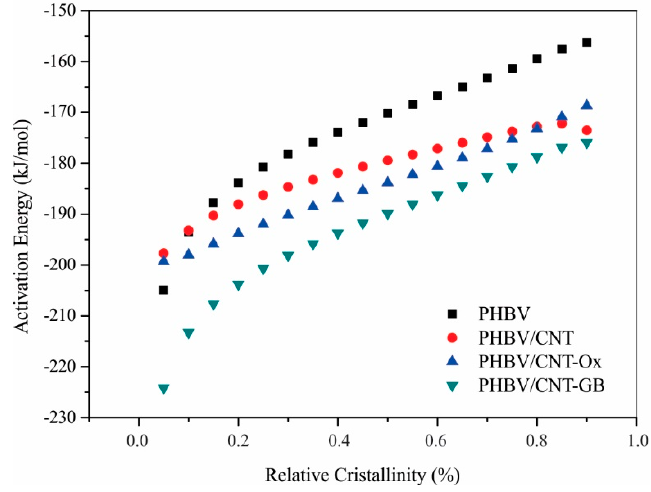
Figure 4. Activation energy versus relative crystallinity at 5 °C/min for PHBV, PHBV/CNT, PHBV/CNT-Ox, and PHBV/CNT-GB nanocomposites.